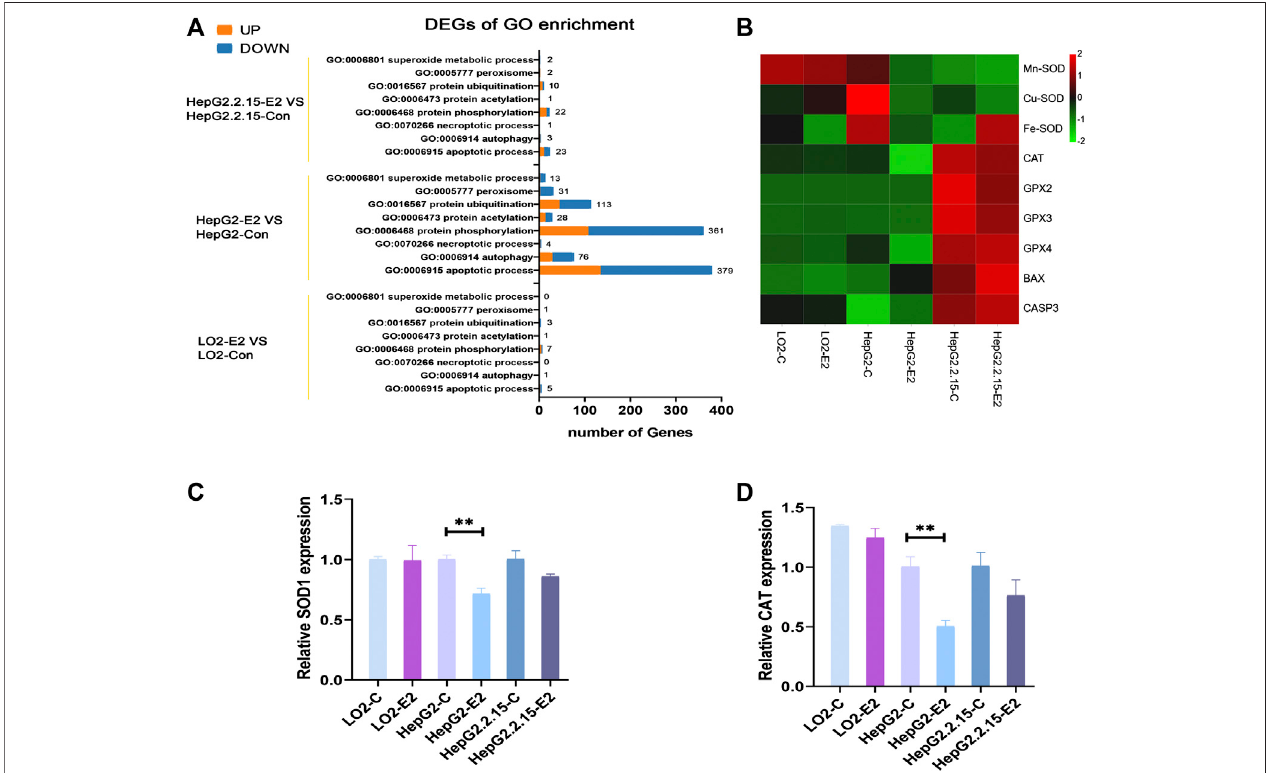
FIGURE 7 | 17 β -estradiol decreased the expression levels of SODs and catalase in HepG2 cells. (A) Enriched Gene Ontology (GO) biological process (B) A heatmap of the enzyme expression levels in the three cell lines. qRT-PCR was used to measure the expression levels of mRNAs encoding SOD1 (C) and catalase (D) in HepG2 cells. ** p < 0.01 compared to the control group.